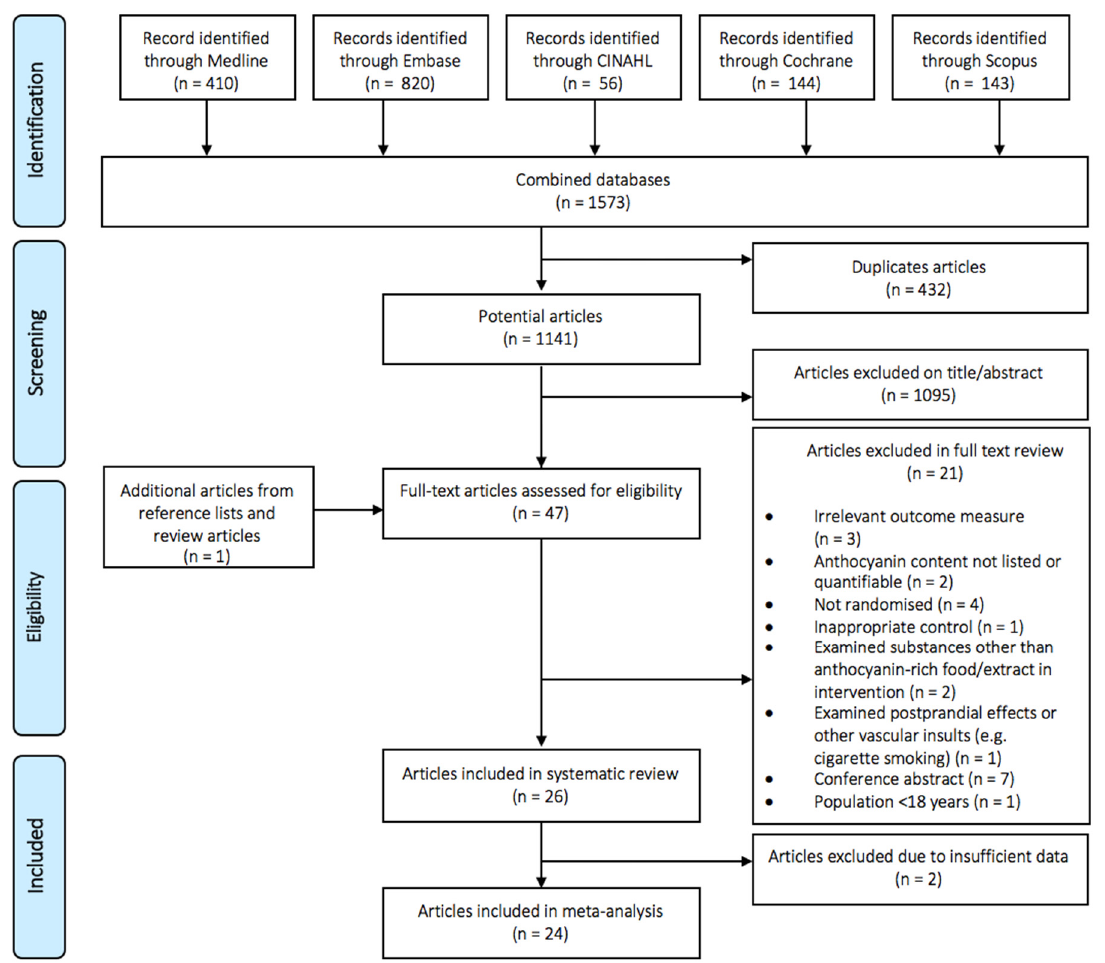
Figure 1. Flow diagram of publication selection.